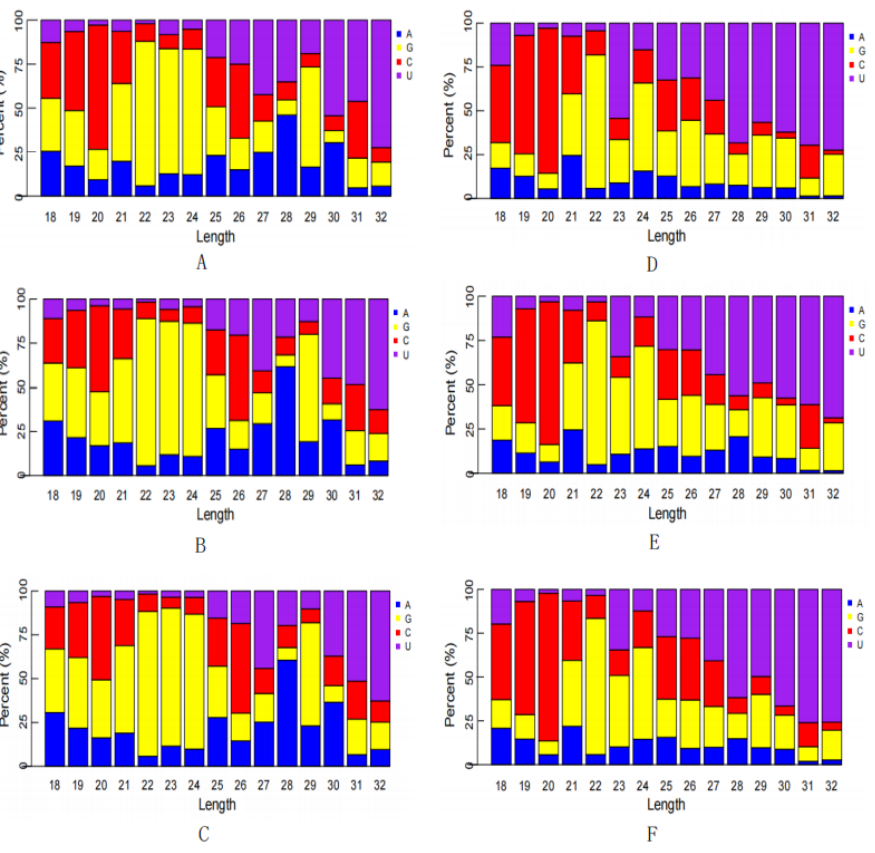
Figure 4. First base bias of miRNAs. ( A – C ) Control group; ( D – F ) infected group.